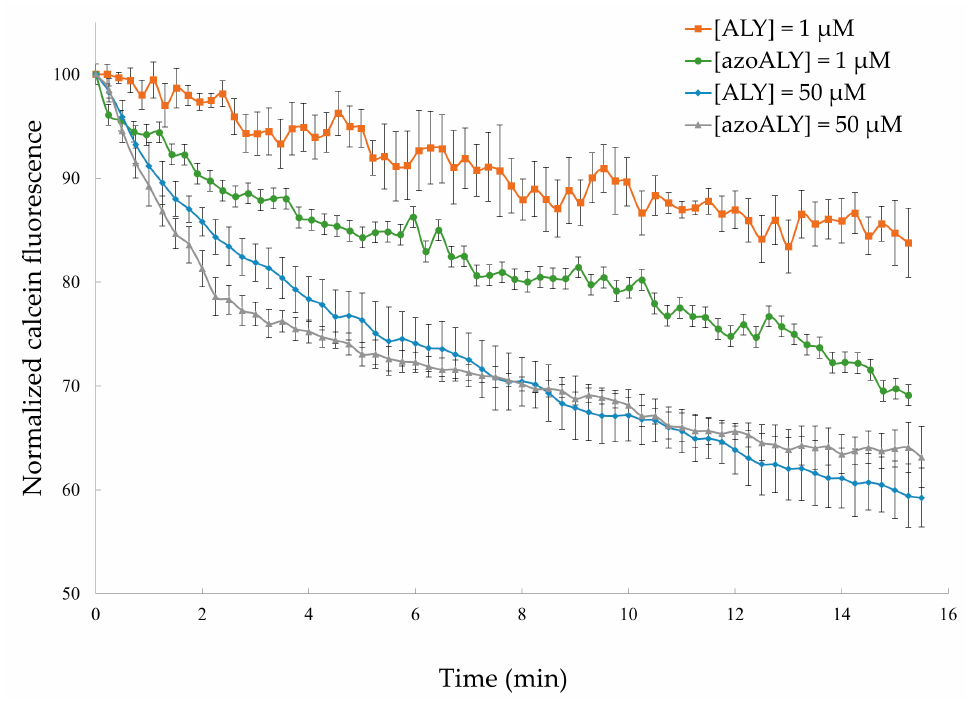
Figure 5. Kinetics of calcein release from POPC / POPG (9:1) GUVs for externally added ALY or azoALY (1 and 50 µ M) using 3 separate vesicles. Control measurements without the addition of peptide showed no calcein release (data not shown).